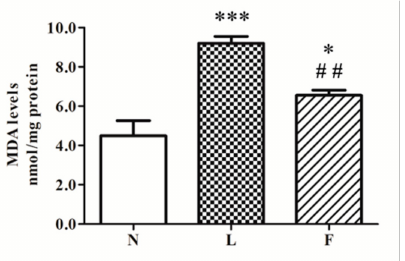
Figure 3. MDA levels. The amount of MDA in total testis homogenate was graphically represented as mean ± SEM of eight di ff erent animal for each group. Significant di ff erences are shown: * p < 0.05 vs N; *** p < 0.001 vs. N; ## p < 0.01 vs. L.